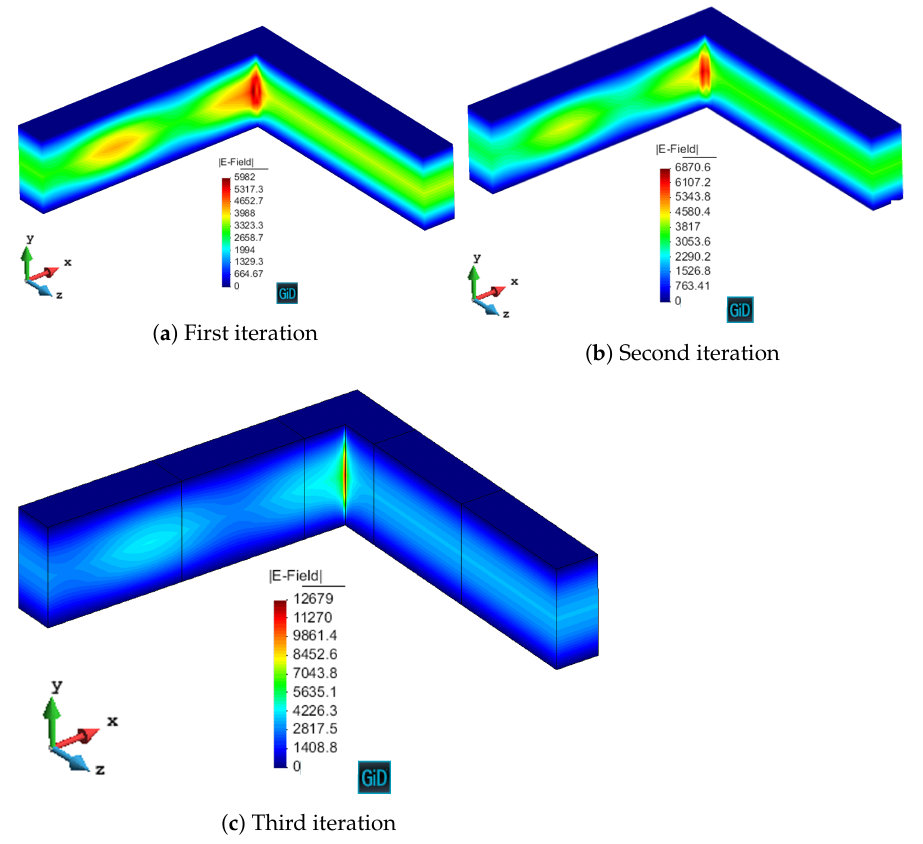
Figure 21. Evolution of the electric field for h refinement in a L-shaped domain.